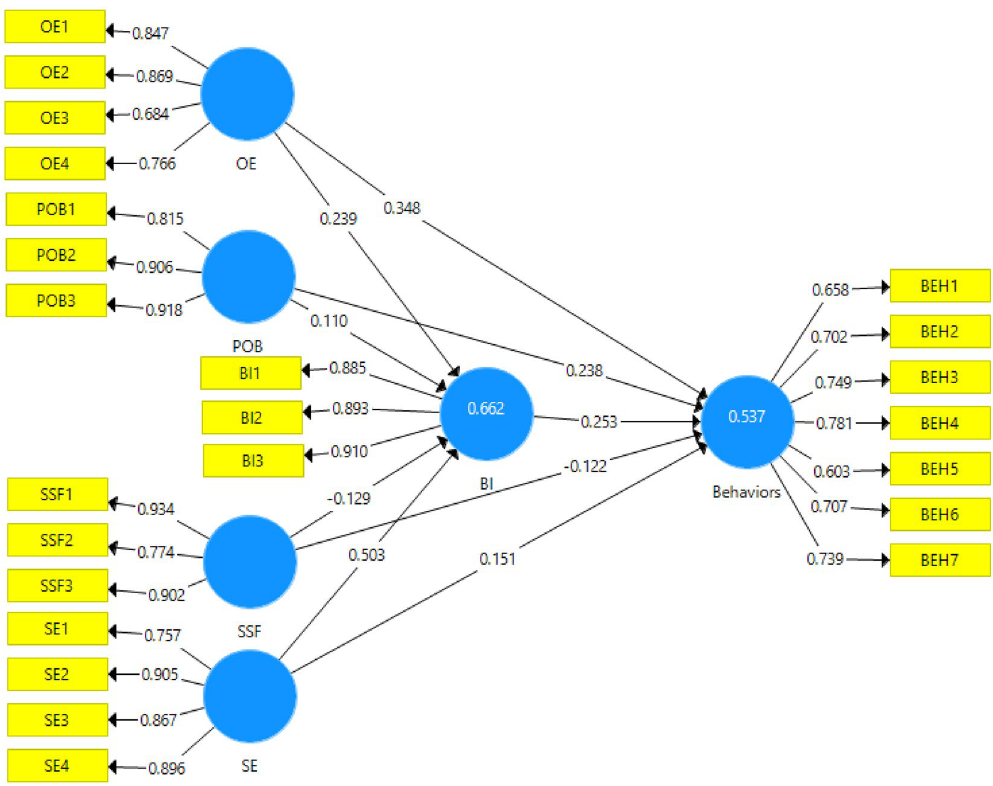
Figure 3. Path model with standardized factor